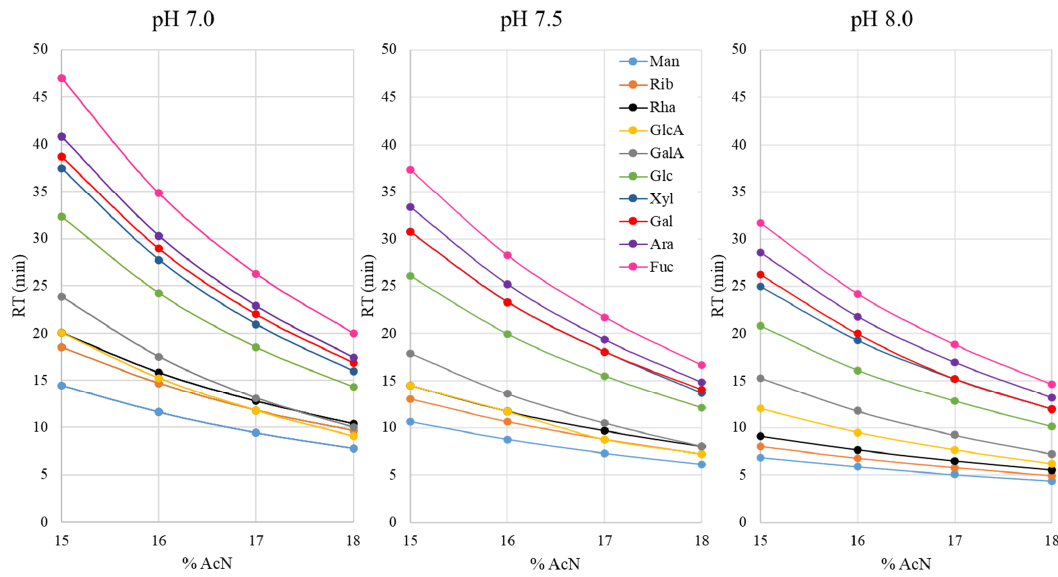
Figure 1. The effects of the pH value of the buffer component of the mobile phase and the organic component content (acetonitrile (AcN)) on the retention times of analyzed PMP-derivatized monomeric sugar standards (Man—mannose; Rib—ribose; Rha—rhamnose; GlcA—glucuronic acid; GalA—galacturonic acid; Glc—glucose; Xyl—xylose; Gal—galactose; Ara—arabinose; Fuc—fucose).